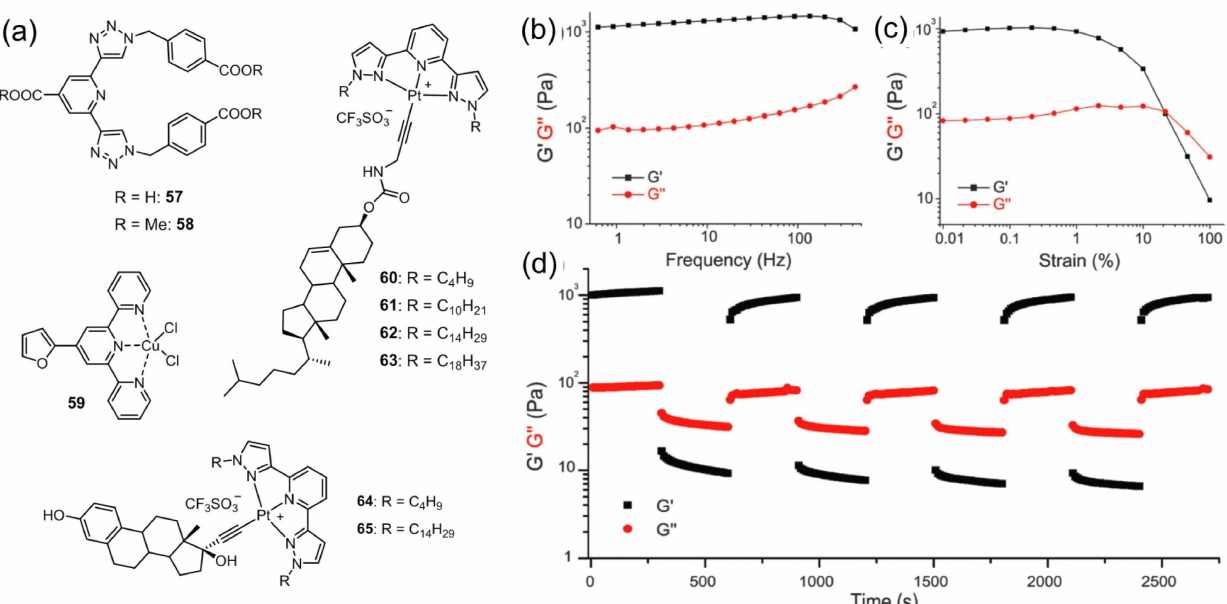
Figure 26. ( a ) Chemical structures of 57 – 65 . Oscillatory rheology measurements of 57 -Eu(III) gel. ( b ) Frequency sweeps at 0.1% strain amplitude of the storage modulus G’ and loss modulus G” are shown. ( c ) The corresponding strain dependence at af = 1 Hz. ( d ) Recovery test for 57 -Eu(III) gel with alternating strain amplitudes of 20% and 0.1% at f = 1 Hz. Reprinted with permission from Ref. [94]. Copyright (2015), Royal Society of